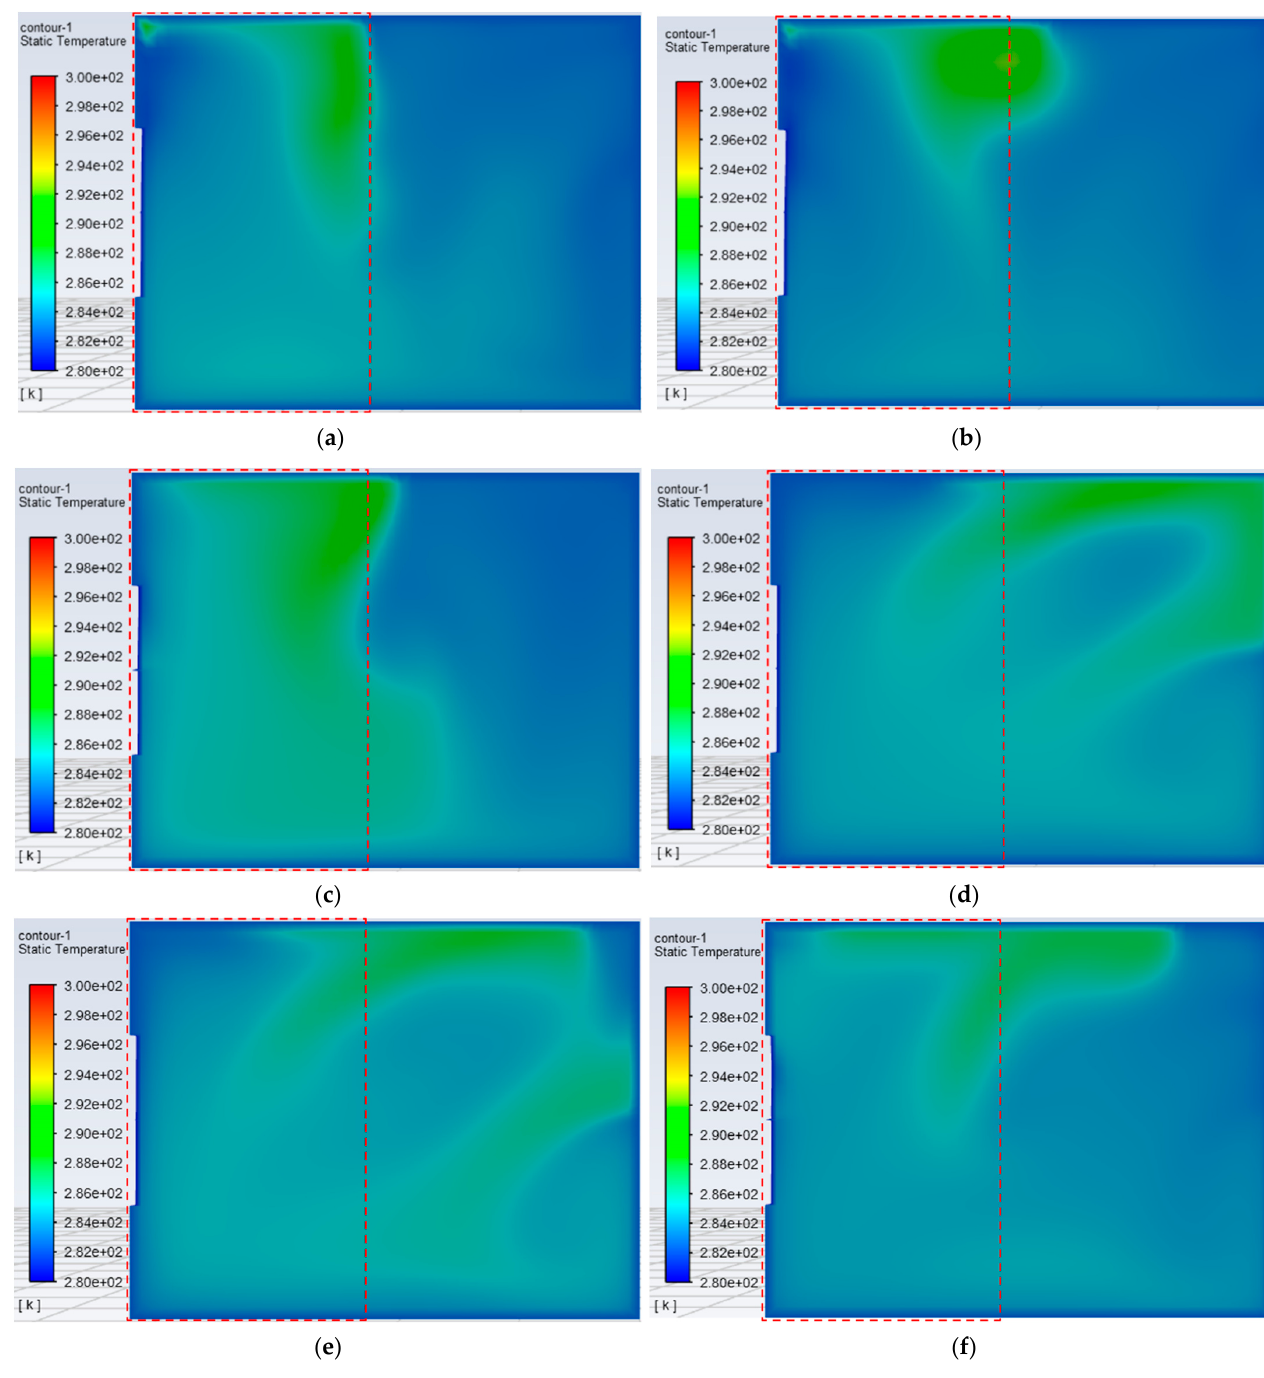
Figure 14. Contours of indoor 1.2 m high plane temperature distribution under six schemes: ( a ) MOUSLE, ( b ) MSUSLE, ( c ) MUSEWP, ( d ) DOUSLE, ( e ) DSUSLE, ( f ) DUSEWP. It can be found through calculation that the indoor air temperature is reduced by an average of 1.3 °C when the above six ventilation schemes are used for ventilation. It can be seen from Figure 14 that when the three ventilation methods of median air supply are used, the areas with higher temperature are mainly distributed on the kang side. Calculating the air temperature of the area where the kang is located and the area where the floor is located, a table is drawn, as shown in Table 6. It can be found that the temperature of the area where the kang is located is 0.63 °C higher when the three median air supply schemes are used than when the three diagonal air supply schemes are used. That is to say, the use of these three ventilation methods of median air supply can reduce the impact of insufficient preheated fresh air on the occupants’ comfort. Table 6. The average temperature of the air on the kang side and the floor side when the ventilation volume is Q = 141 m 3 /h. 284.88 K The air flow rate should not be too high in the areas where people need to stay in- doors for a long time, otherwise it will cause discomfort to the people and even affect the daily activities of residents. It is required in the “Design Code for Heating Ventilation and Air Condition of civil buildings (GB50736-2012)” that the average air velocity of indoor